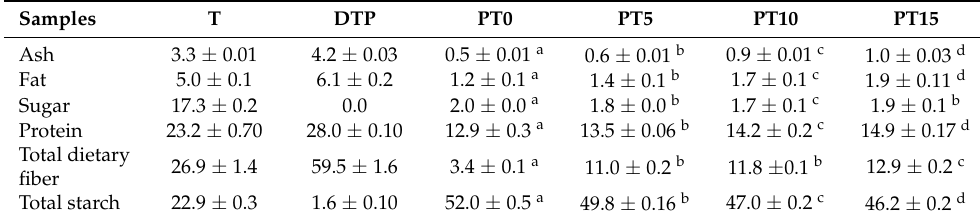
Table 1. Chemical composition of trub (T), debittered trub powder (DTP) (g/100 g dry matter)